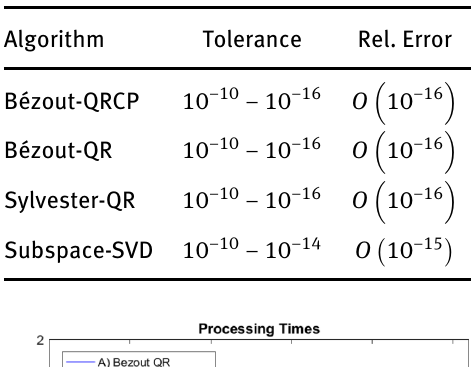
Table 3: Numerical relative error for the GCD of the set (37) in Example 2.